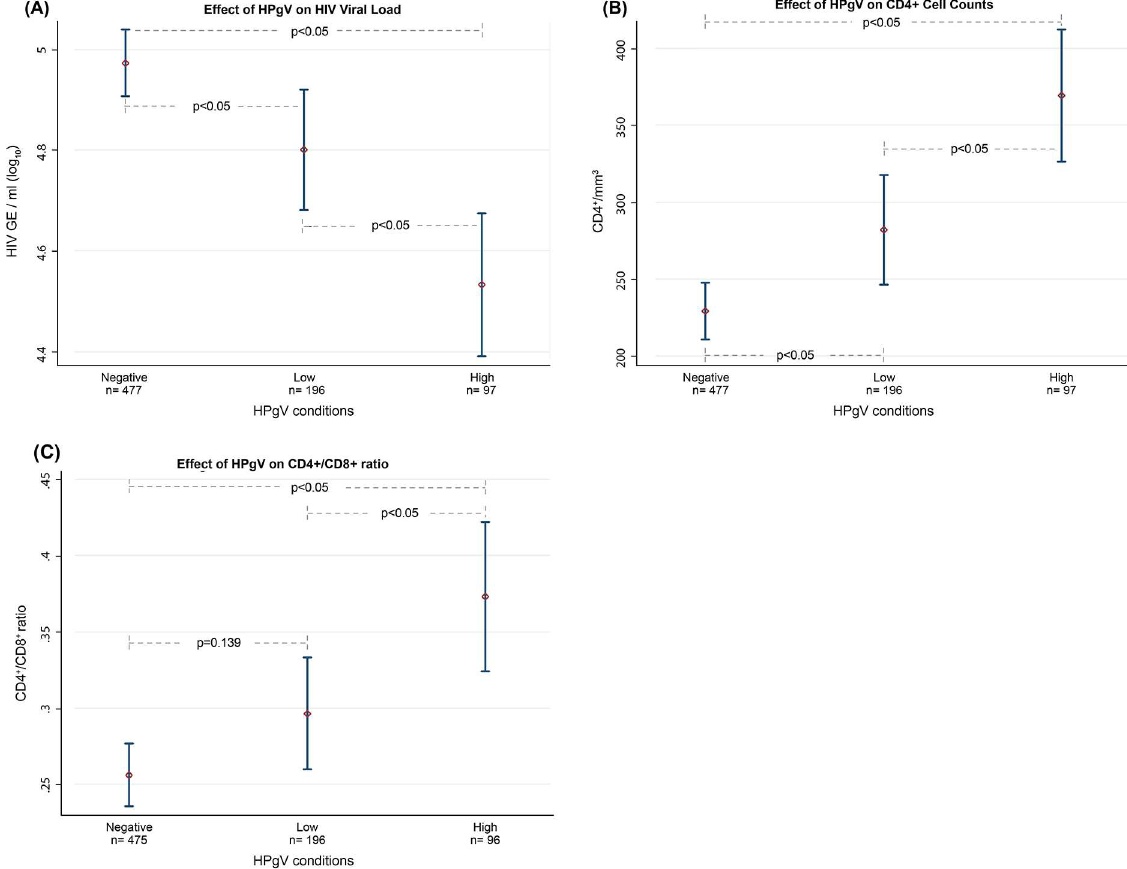
Fig 3. Effects of HPgV on surrogate markers of HIV progression. Each graph shows the differences betweenthe means of: (A) HIV viral load/ml(log 10 ), (B) CD4 + cell counts (CD4 + /mm 3 ), and (C) CD4 + /CD8 + ratio, in the ART-na ï vepopulation accordingto their HPgV condition(-negative, -low, or -high). Significantdifferences are considered at p < 0.05.